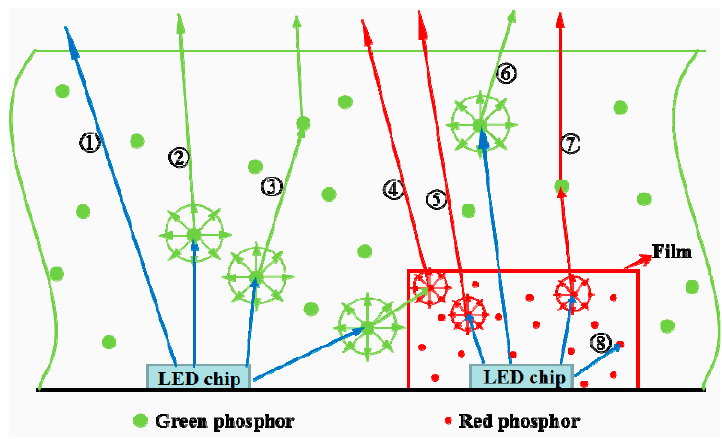
Figure 9. Luminescence mechanism of stacked type packaged filament.